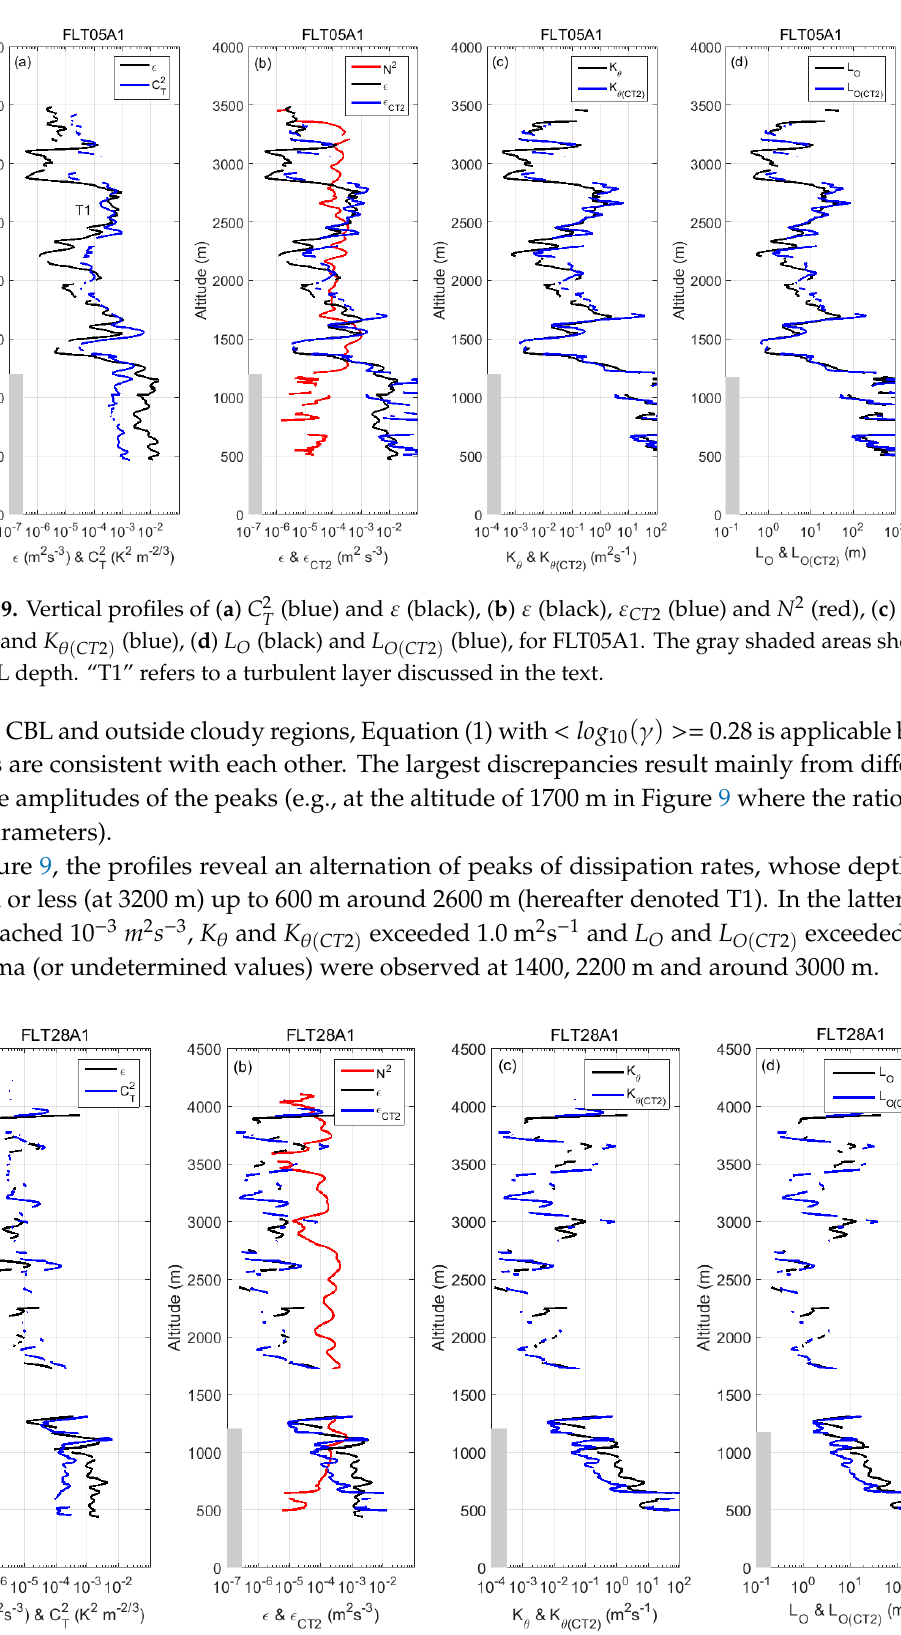
Figure 10. The same as Figure 9 for FLT28A1. The gray shaded areas show the CBL depth.